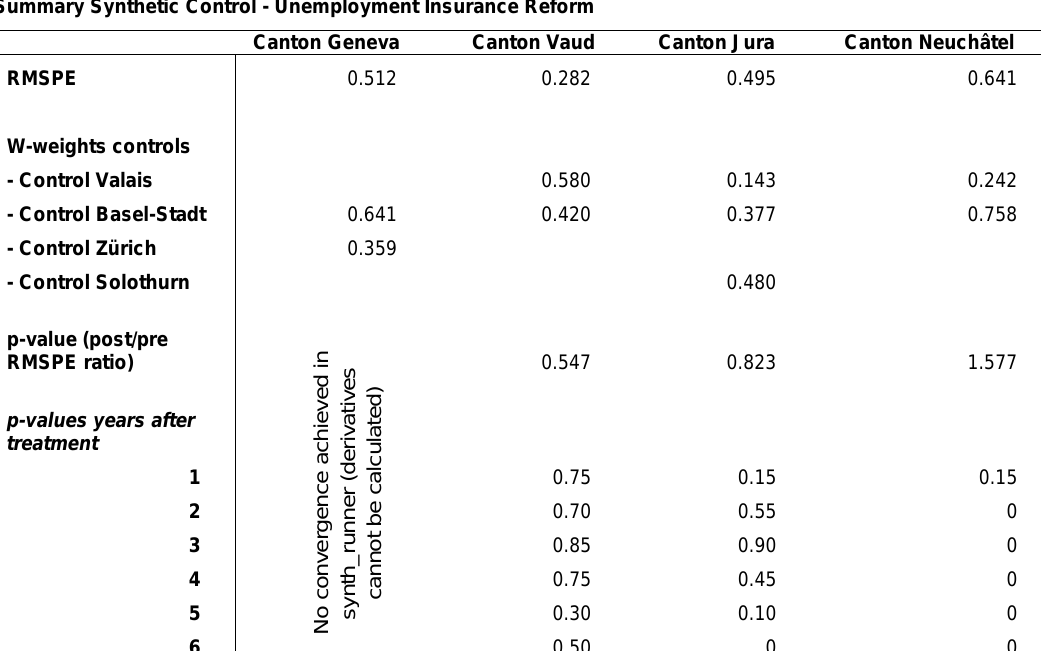
Table 6. Summary of the SC computation of other cantons affected by the new policy. Summary Synthetic Control - Unemployment Insurance